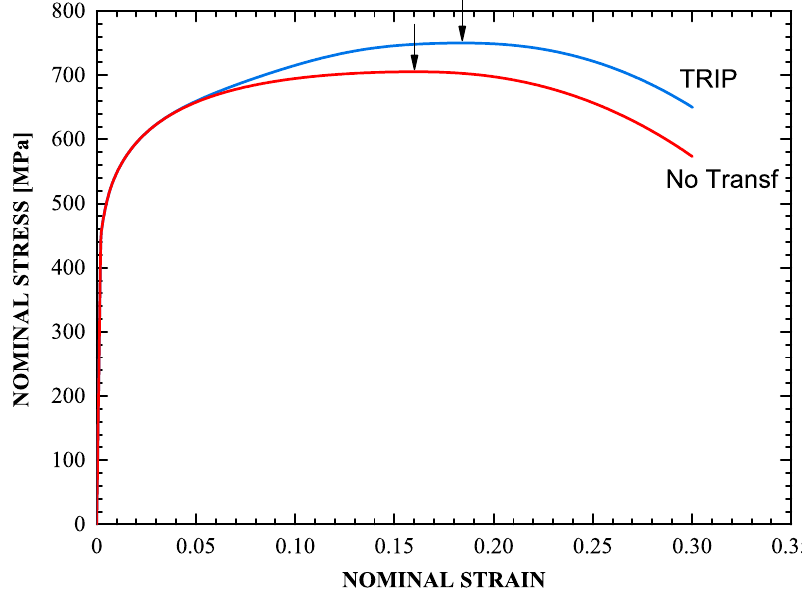
Figure 15. Stress-strain curves for a transforming steel and a “non-transforming” steel. The arrows show the position of the maximum